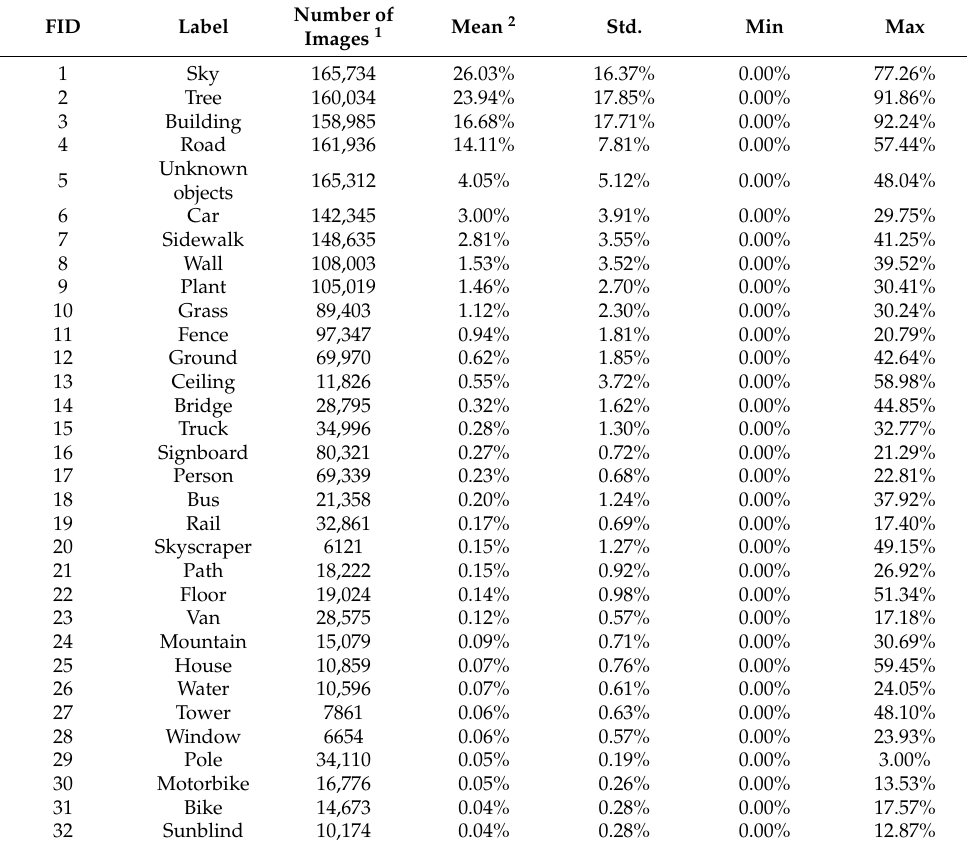
Table A2. Statistical description of features extracted by Semantic segmentation sorted by